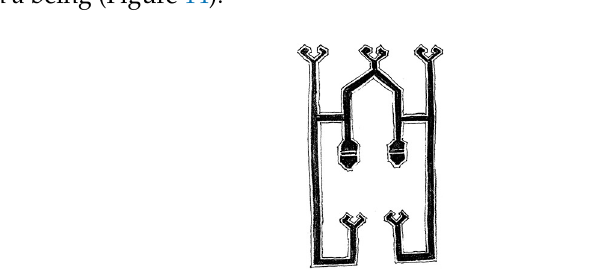
Figure 14. The “being” that appears in the Seljuk prayer carpet. Source: { Foreshadowing }